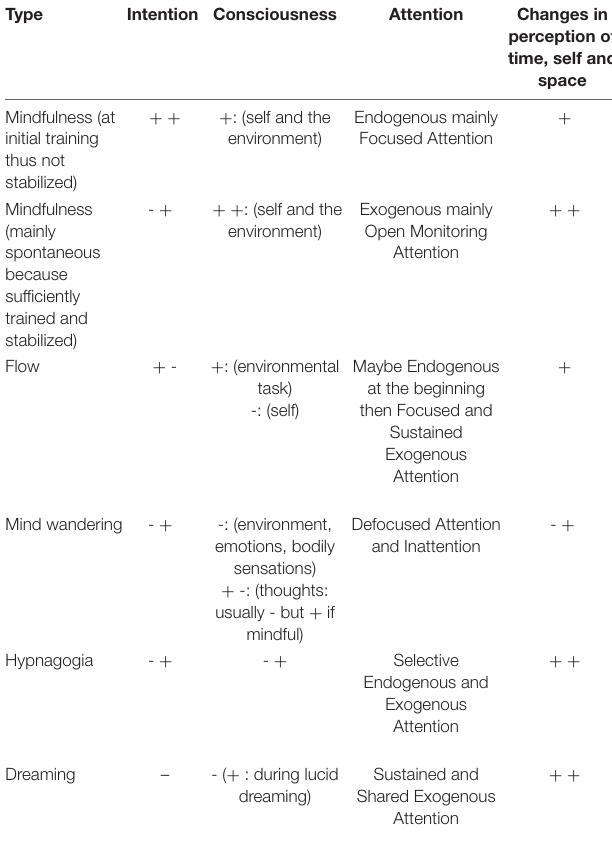
TABLE 1 | Typology of attentional states of consciousness. Type Intention Consciousness Attention Changes in